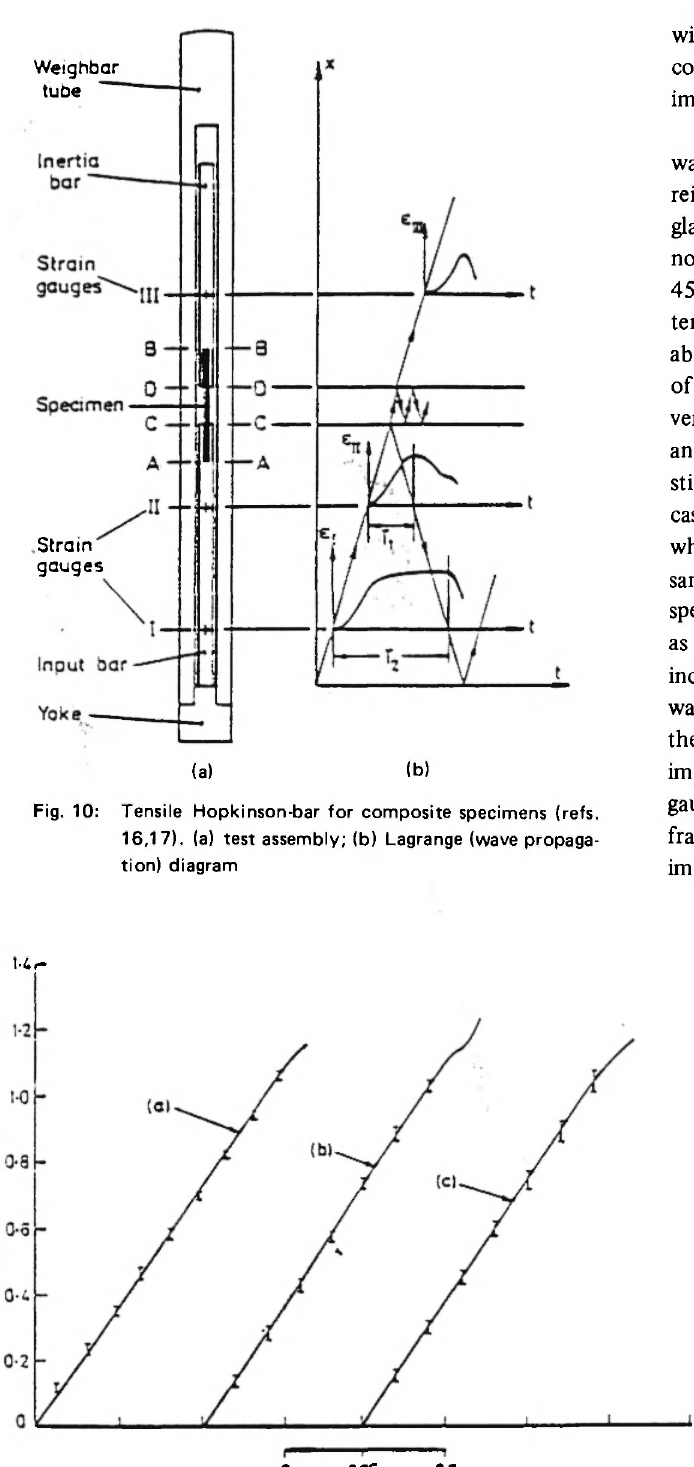
Fig. 11: Effect of strain rate on composite tensile stress-strain curves (refs.